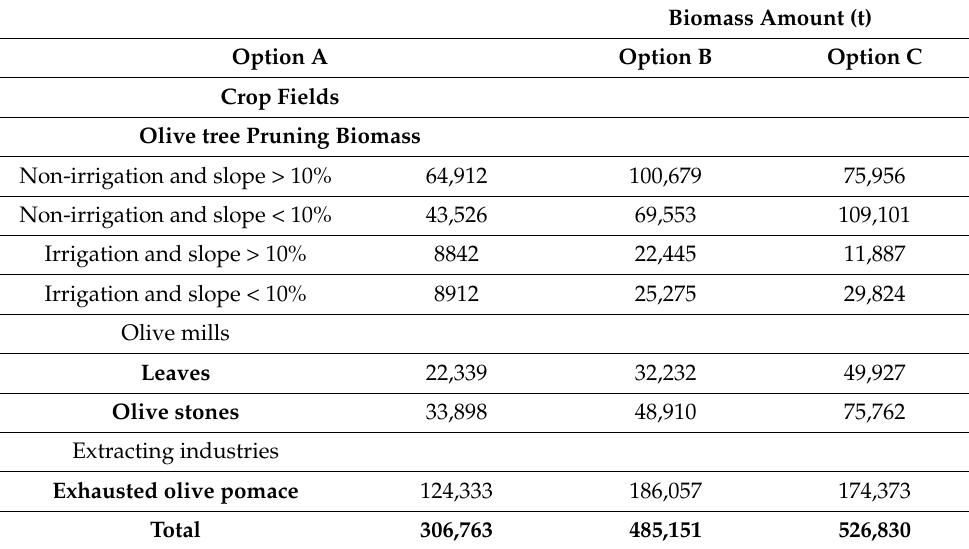
Table 4. Olive biomass availability for the biorefineries in the selected